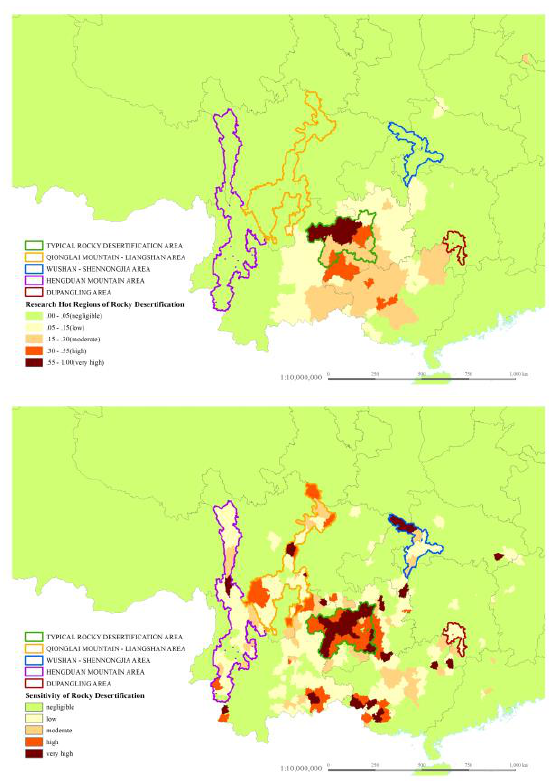
Figure 6. Comparison of Research Hot Regions and Sensitive Regions.